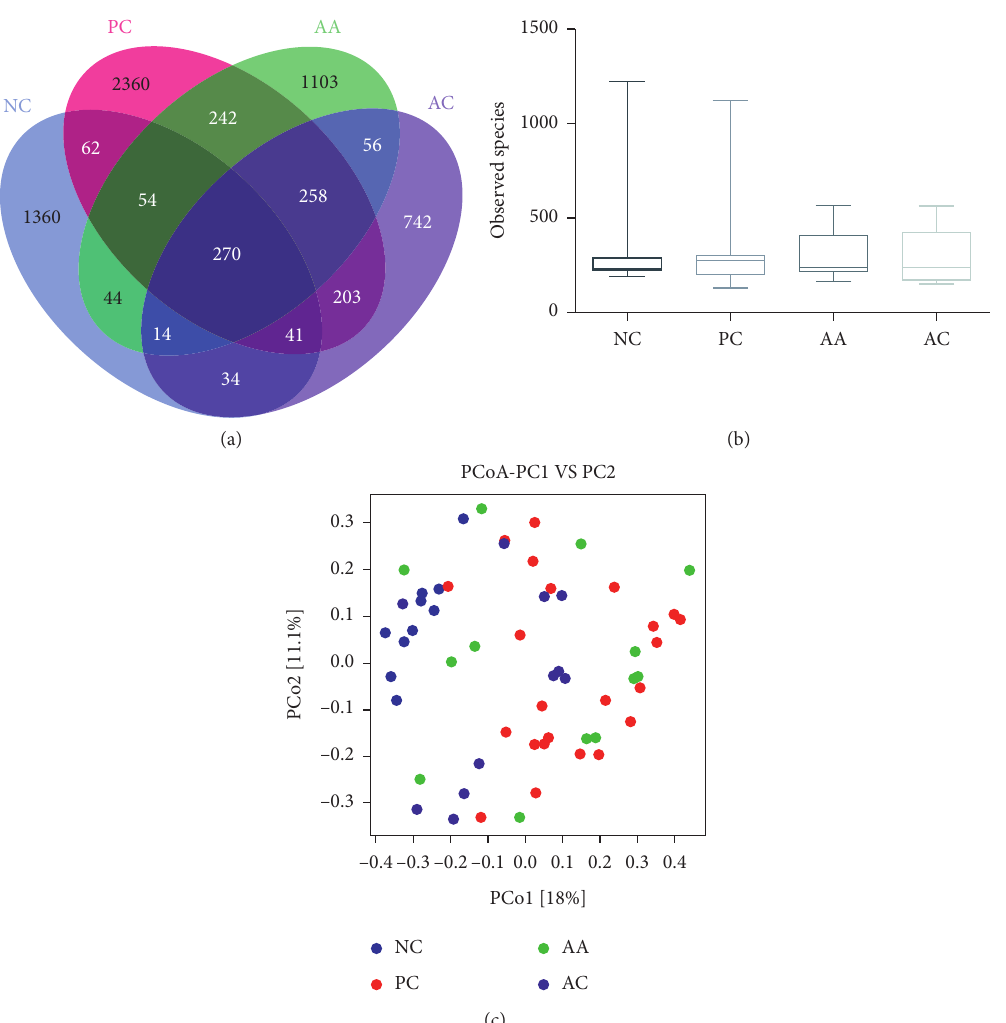
Figure 2: Evaluation of aloe vera fermentation gel on α -diversity (within samples), β -diversity (between samples), and Venn diagram representation. (a) Common OTUs’ Venn diagram. (b) Observed species. (c) Principal coordinates analysis